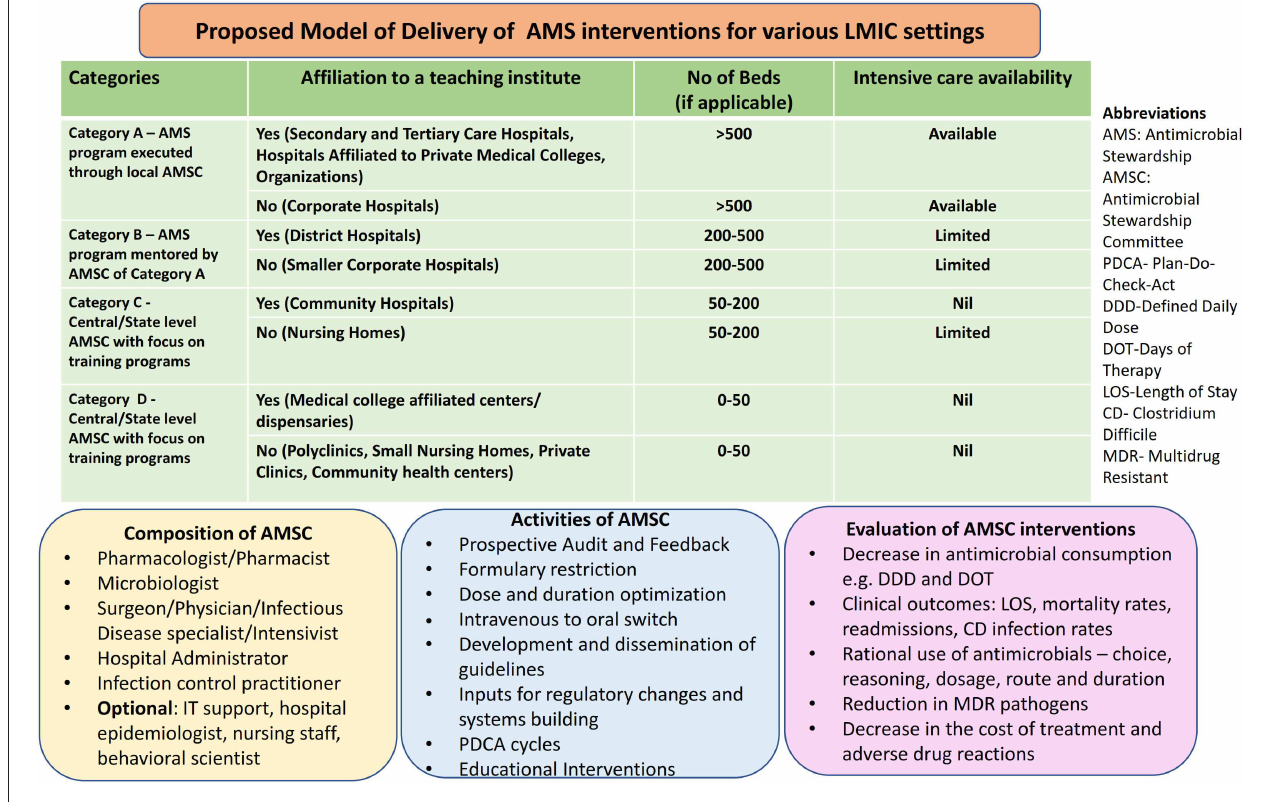
FIGURE 2 | Proposed model of delivery of AMS interventions for diverse LMIC